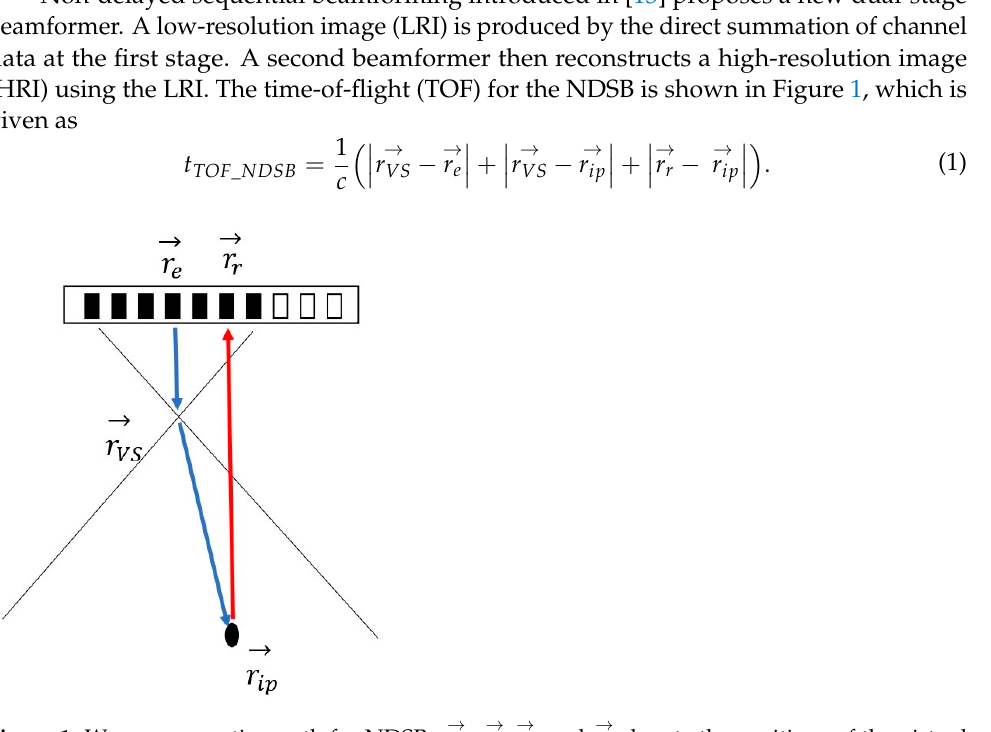
Figure 1. Wave propagation path for NDSB. 𝑟 (cid:3023)(cid:3020) (cid:4652)(cid:4652)(cid:4652)(cid:4652)(cid:4652)⃗ , 𝑟 (cid:3045) (cid:4652)(cid:4652)⃗ , 𝑟 (cid:3032) (cid:4652)(cid:4652)(cid:4652)⃗, and 𝑟 (cid:3114)(cid:3043) (cid:4652)(cid:4652)(cid:4652)(cid:4652)⃗ denote the positions of the virtual source, the receive element, the transmit origin, and the imaging point, respectively. The blue arrows indicate the transmit path, and the red arrows indicate the receive path. The active elements are indicated as black.